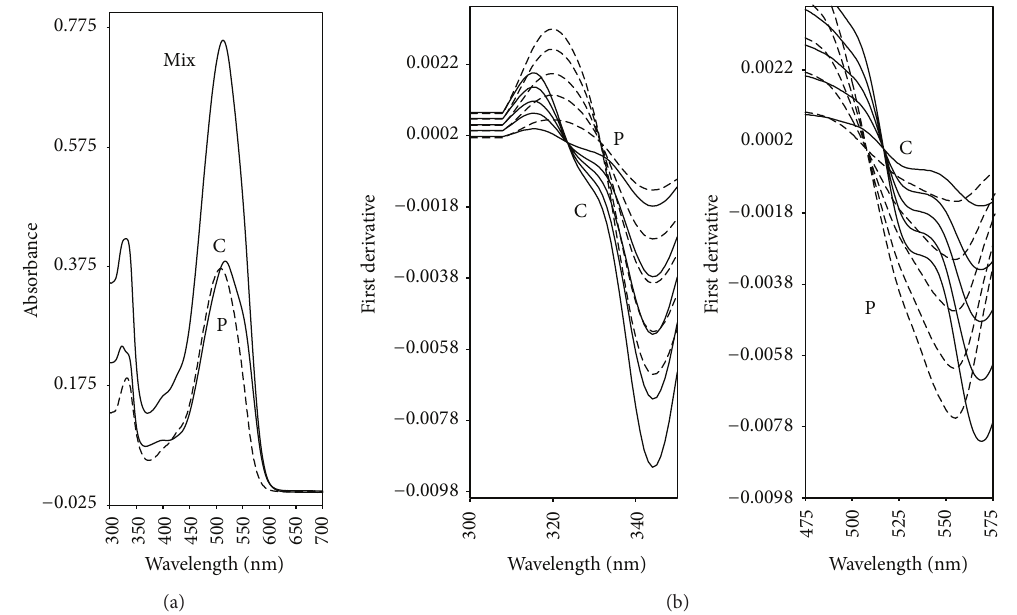
Figure 1: Zero-order spectra (a) of 10 𝜇 gmL −1 Carmoisine, 10 𝜇 g mL −1 Ponceau 4R, and their binary mixture; first derivative spectra (b) of colorants (Carmoisine(—): 2–10 𝜇 gmL −1 ; Ponceau 4R (--): 2–10 𝜇 g mL −1